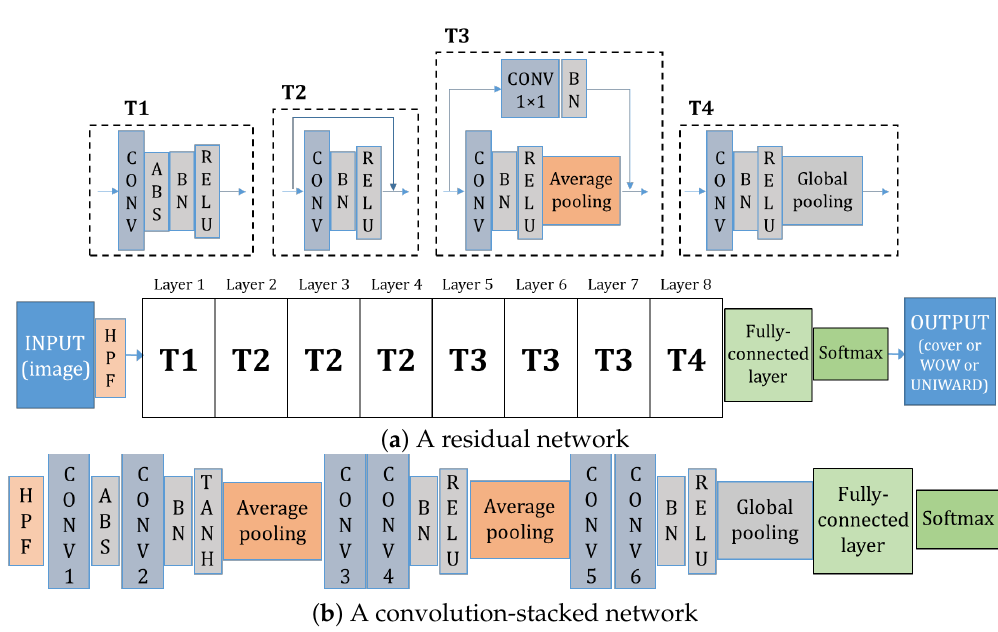
Figure 12. Deep residual network and convolution-stacked network for ternary classification. Table 6. Ternary classification rates of the residual and convolution-stacked networks of Figure 12 ( bpp =